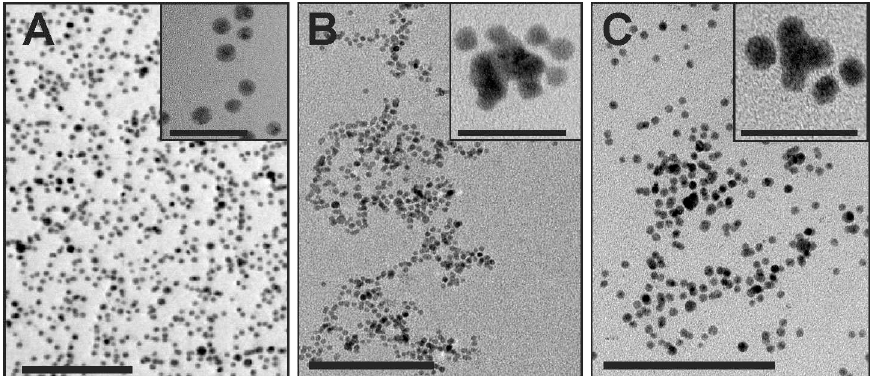
Figure 8. High-resolution transmission electron micrographs of different 5 nm AuNPs: ( A ) neutral, ( B ) negatively and ( C ) positively charged nanogold. Insets indicate high magnification of selected AuNPs. Scale bars: A–C = 100 nm; insets A–C = 20 nm.